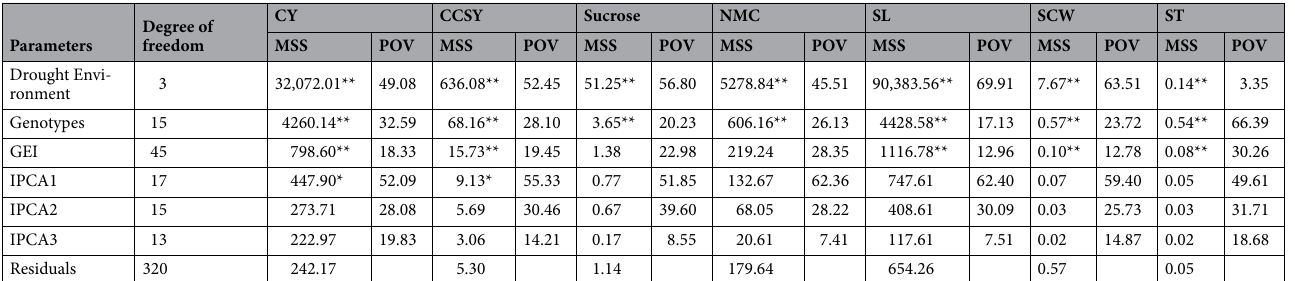
Table 5. Analysis of variance for cane yield, sucrose and component traits by using AMMI model under drought stress in sugarcane. **significant at 1% level; *significant at 5% level. MSS mean sum of squares, POV percent of variation explained by components, CY cane yield (t/ha), GEI genotype × environment interaction, IPCA Interactive principal component axis, CCSY commercial cane sugar yield (t/ha), Brix12: juice brix at 12th